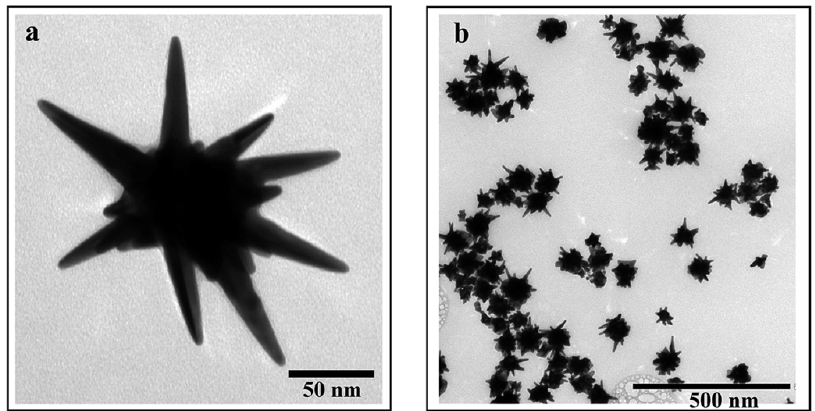
Figure 6. AuNSs images acquired by Transmission Electron Microscopy (TEM) at different magnifi- cations: 50 nm scale bar ( a ) and 500 nm scale bar ( b ) [32].